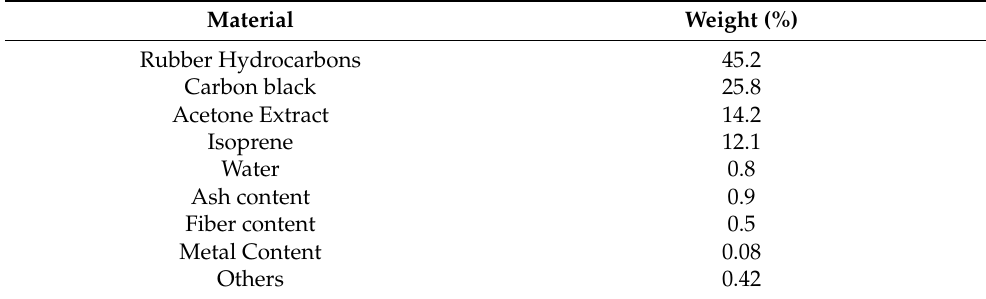
Table 3. Chemical composition of crumb rubber [59].